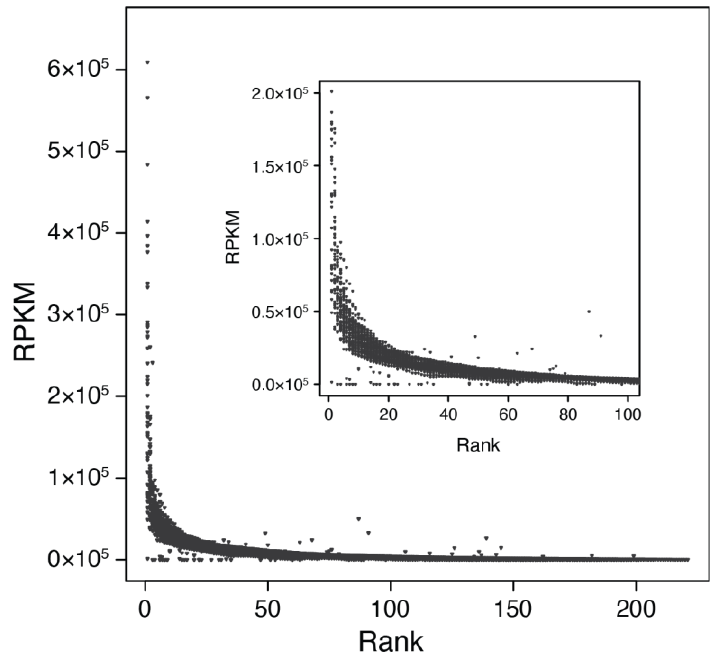
Figure 5. Rank abundance curve for all viral species across all viral fraction metagenomes. Insert shows ranks between 1 and 100. Viral species abundance depicted on the y -axis is read coverage (RPKM). The shape of this rank abundance curve is typical of microbial communities with a few very abundant species in any given sample and numerous less abundant species.